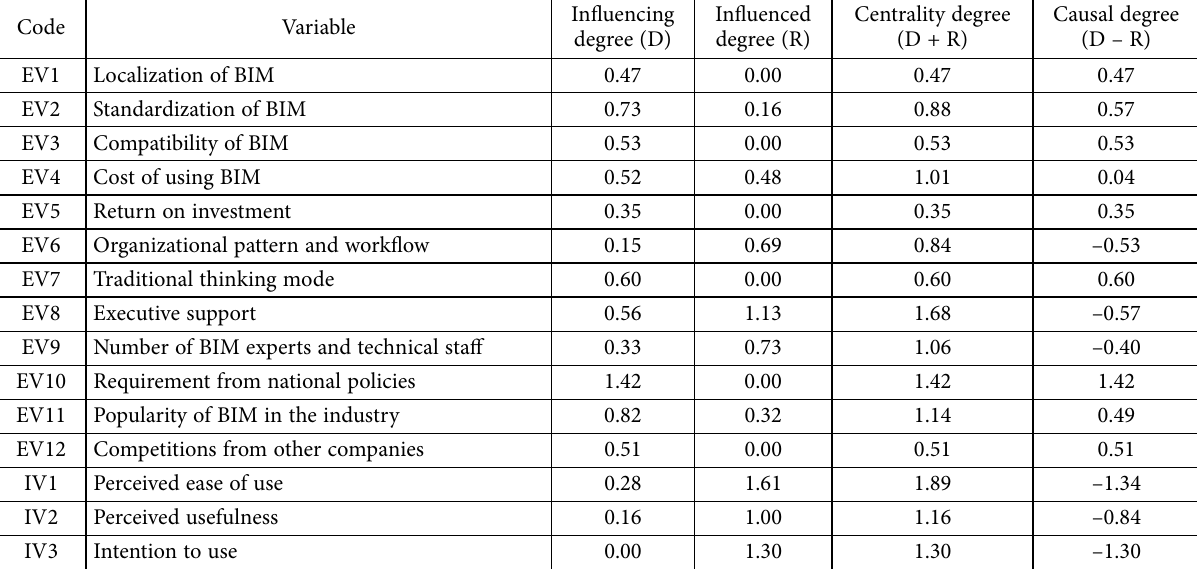
Table 9. TAM-TOM causal influence level summarized